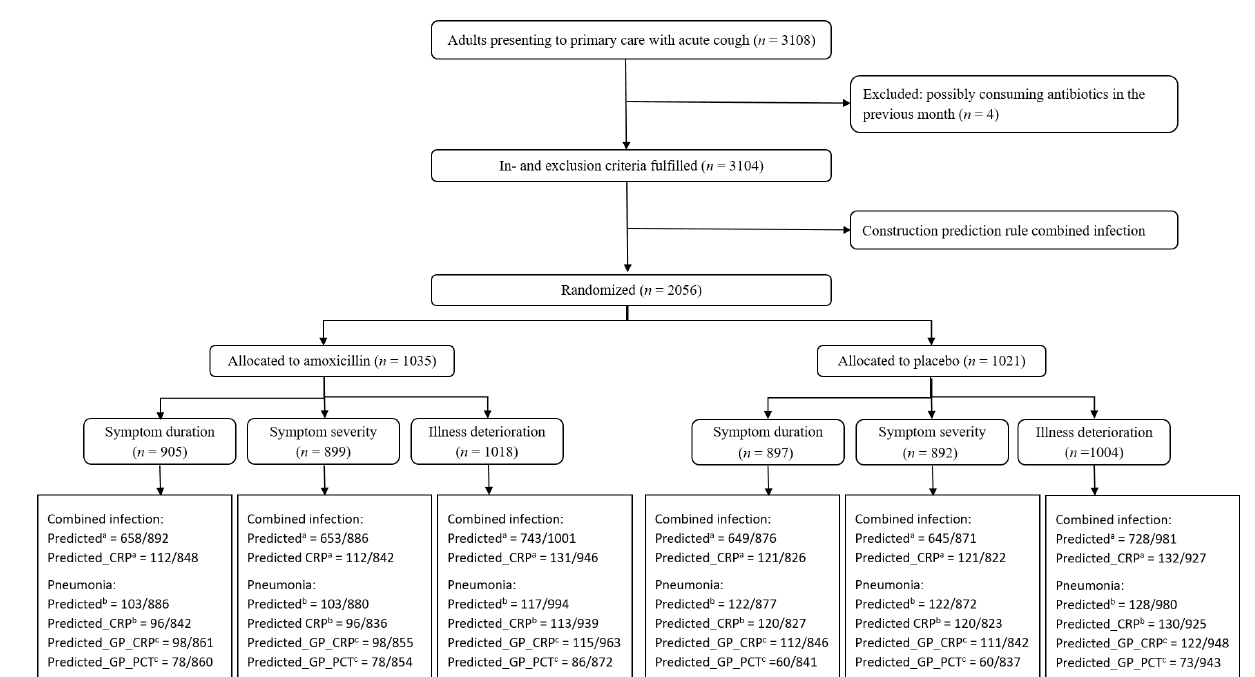
Figure 2. Patient flow chart. a patients predicted to have a combined infection based on the prediction rule constructed in this manuscript without (predicted) and with (predicted_CRP) inclusion of CRP; b patients predicted to have a pneumonia based on the prediction rule constructed by Van Vugt et al. without (predicted) and with (predicted_CRP) inclusion of CRP; c patients predicted to have a pneumonia based on the GP’s suspected diagnosis with inclusion of CRP (predicted_GP_CRP) or PCT (pre- dicted_GP_PCT).